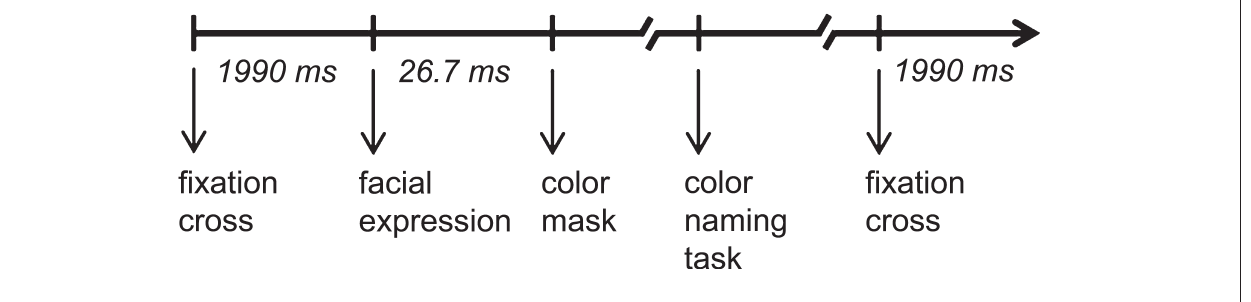
FIGURE 1 | Time line for a single trial of the emotional Stroop